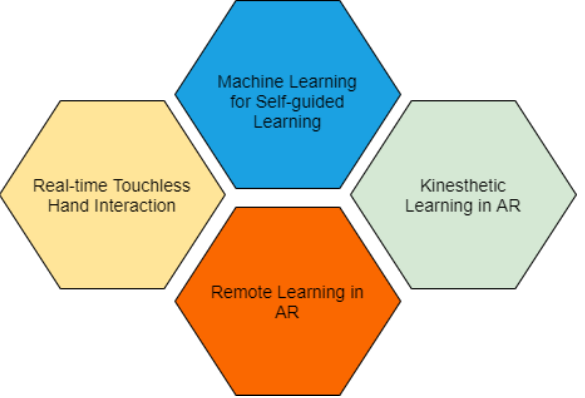
Figure 7. Four core components of a future research approach in this